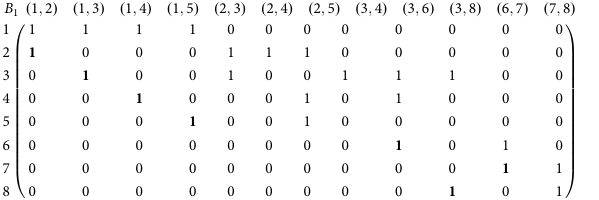
Fig. 1. It should be noted that the minimum k th-order spanning trees are not unique in general.